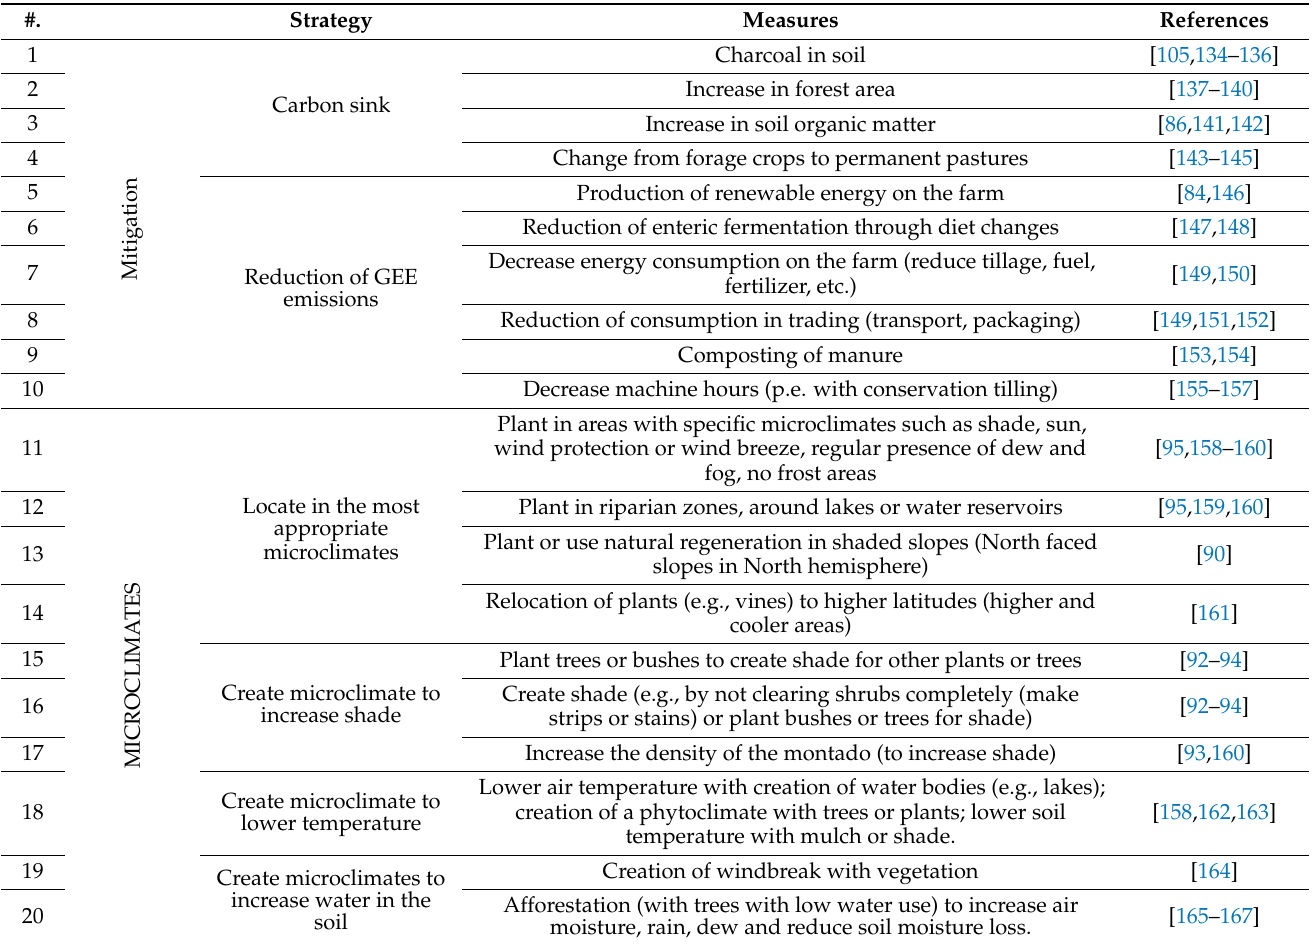
Table A1. Climate Adaptation Measures for the Agriculture and Forestry sector in the Mediterranean Climate. These measures are compiled from 151 different references listed